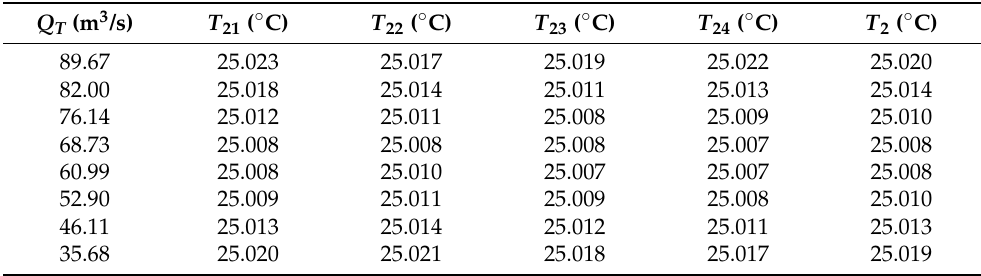
Table 8. Manifold ´ s temperature, low-pressure section.